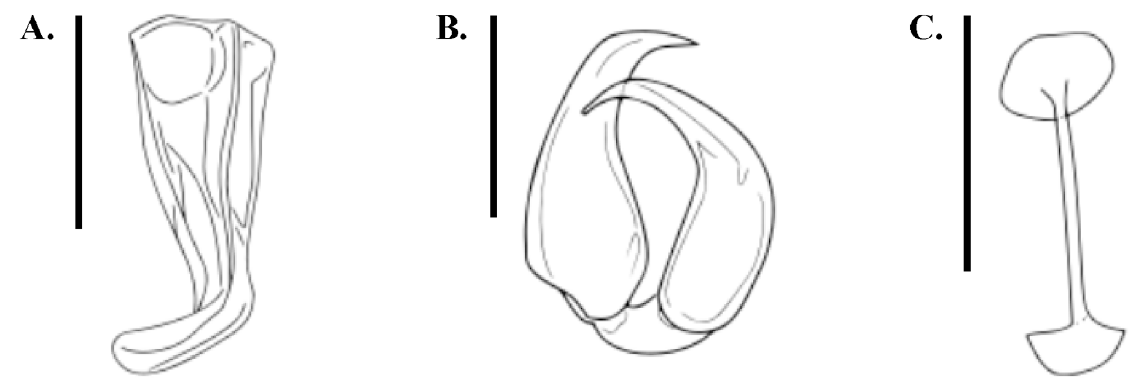
Fig. 4. Diascorhynchus caligatus Ax, 1959 (HU X.2.07). A . Stylet. B . Proboscis hooks. C . Sclerotised spermatic duct. Scale bars: 20